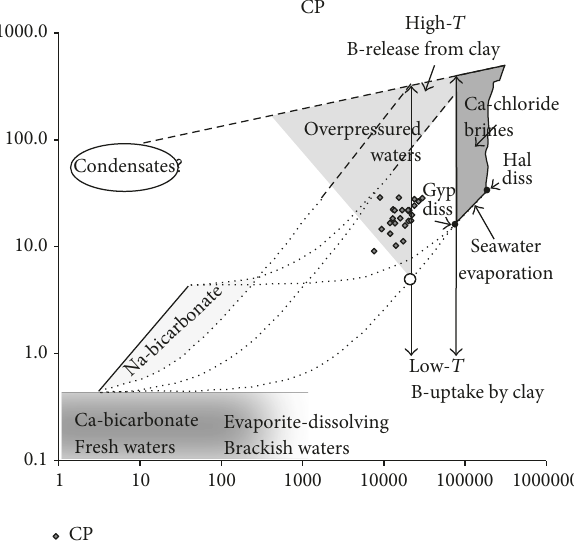
Figure 6: CP overpressure: chloride versus boron concentration (mg/L; fields and paths from [3]). Dashed lines represent binary mixings where specific geological environments dominate. Dia- monds correspond to the CP sampled